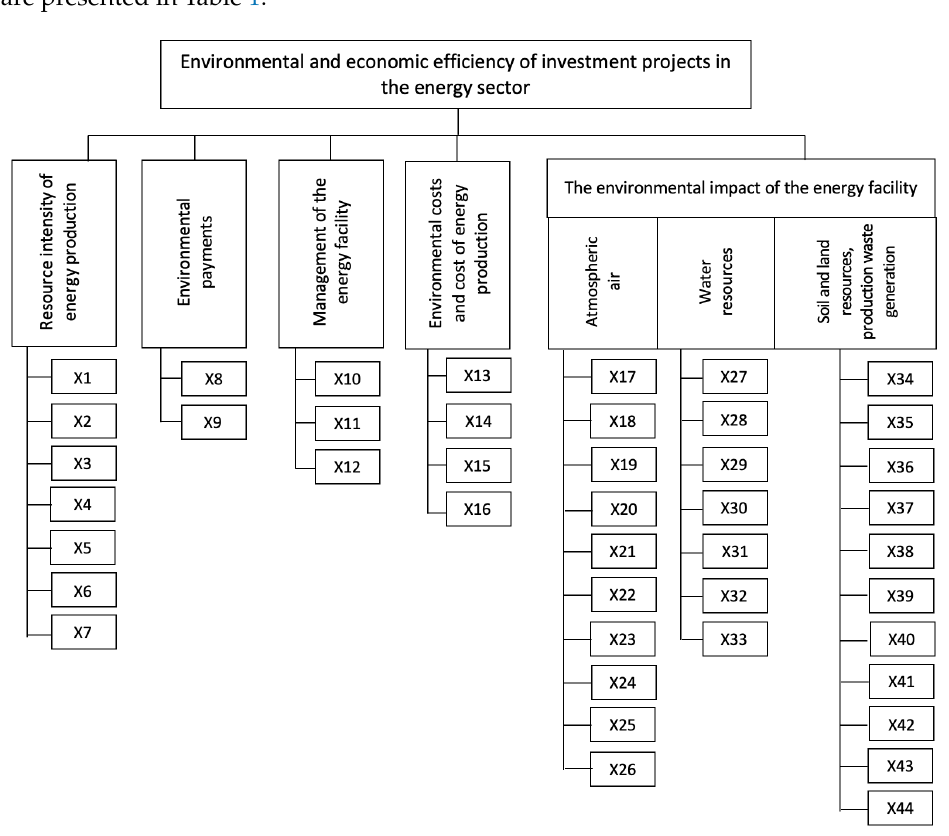
Figure 2. Classification of factors determining the environmental and economic efficiency of energy investment projects. Table 1. Names of factors determining the environmental and economic efficiency of investment projects in the energy